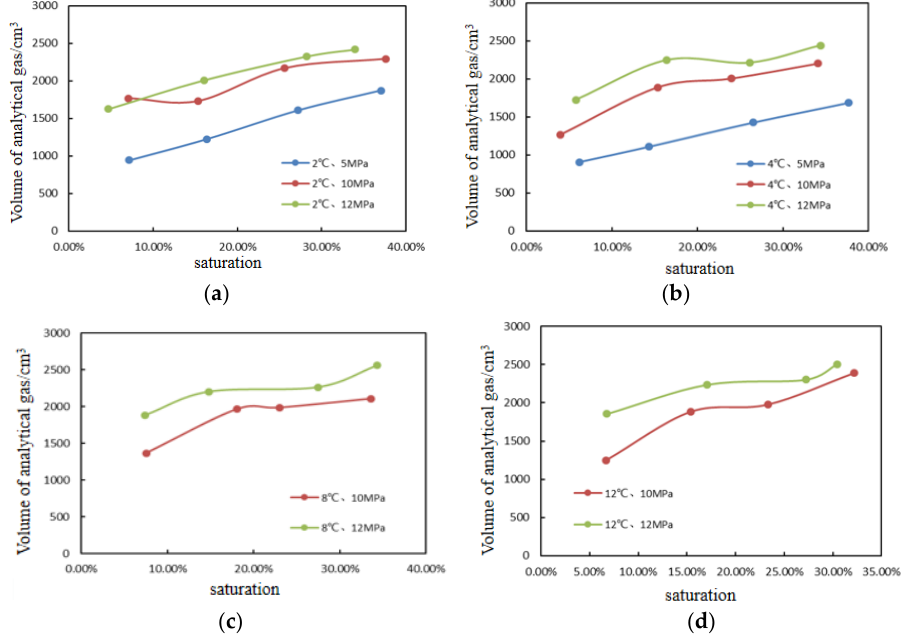
Figure 4. Relationship between analytical gas and saturation of hydrates ( a ) The test temperature is 2 °C; ( b ) The test temperature is 4 °C; ( c ) The test temperature is 8 °C; ( d ) The test temperature is 12